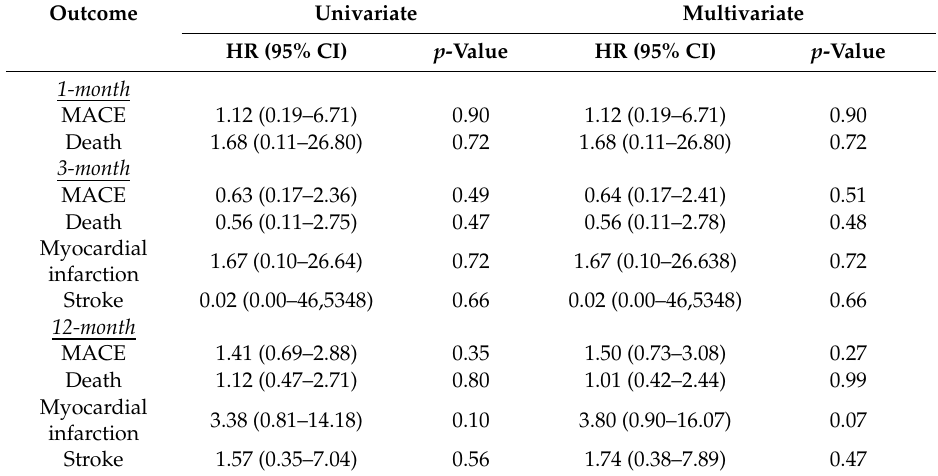
Table 5. MACE outcomes at 1, 3, and 12 months between SAPT ( n = 149) and DAPT ( n =